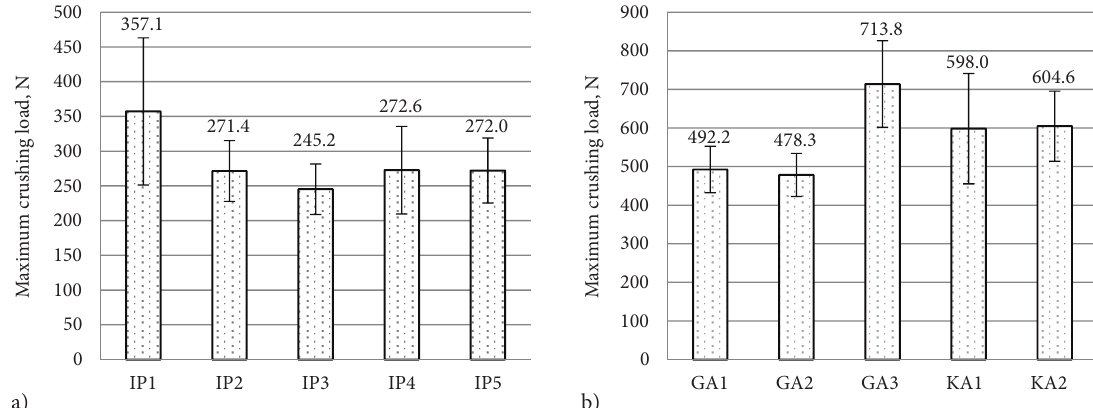
Figure 5. Maximum crushing load test results for a) Industrial granules IP and b) Experimental granules GA and